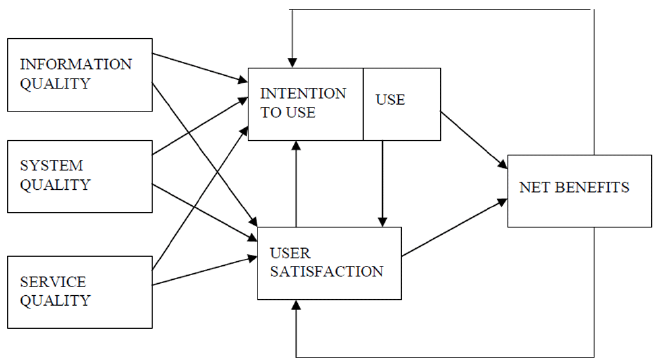
Figure 3. The DeLone and McLean model